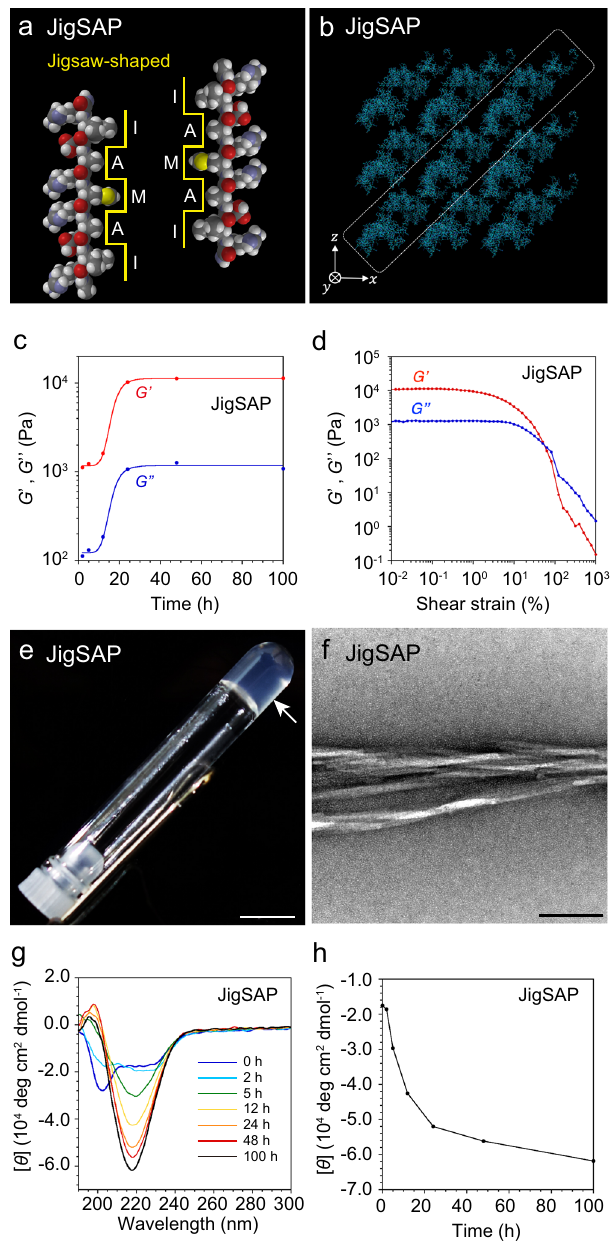
Fig. 1 Hydrogel formation by JigSAP with micrometer-long nano fi bers, robustness and high dispersibility. a Space- fi lling models of Ac- niche for regulating cellular responses such as proliferation, RIDARMRADIR-NH 2 (JigSAP), showing the jigsaw-shaped hydrophobic surfaces. b A snapshot of supramolecular structures of JigSAP in water at 310K obtained by all-atom MD simulation. c Strain-dependent storage ( G ’ , adhesion 1,2 . For example, secreted proteins belonging to the red) and loss ( G ” , blue) modulus pro fi les of JigSAP in DMEM proteoglycans and generate the morphogen gradient essential for proper development 3,4 . Covalent modi fi cation of cholesterol by hedgehog family proteins is essential for the morphogen gradient 3,4 and is believed to regulate their binding to and release from heparan sulfate proteoglycans 5 . Covalently modi fi ed secre- ted proteins ef fi ciently bind to and release from ECMs during injured tissue regeneration if the ECMs remain intact after injury. (PIGF-2) and laminin α subunit have high af fi nity to ECMs.